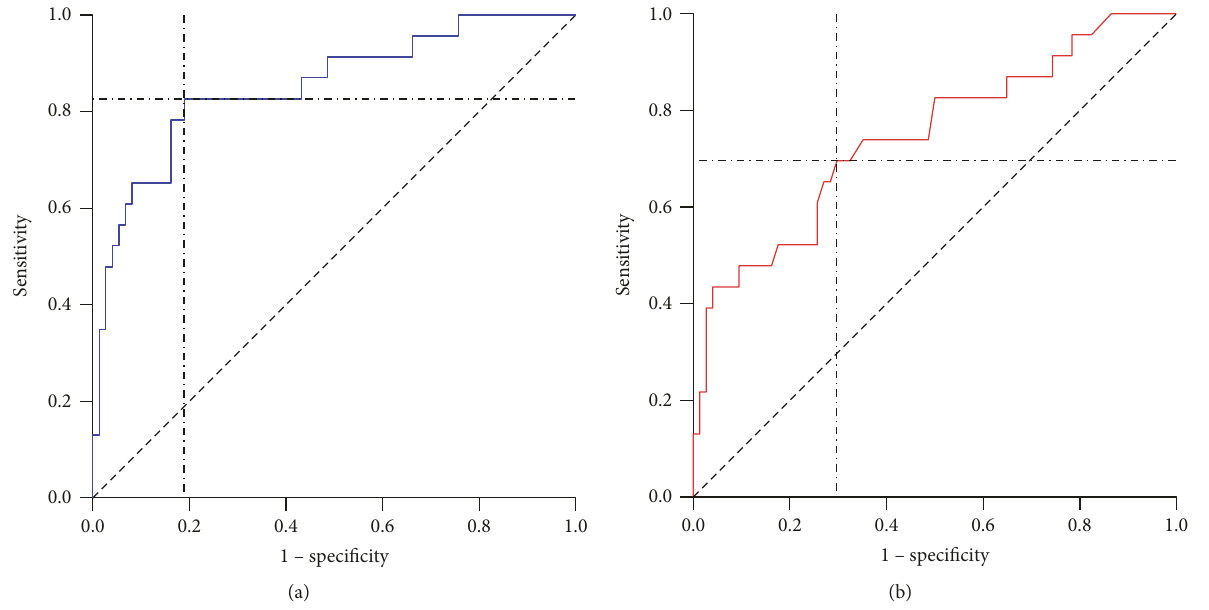
Figure 3: Receiver operating characteristic curve used to determine threshold values of isthmus length related to successful radioactive iodine therapy in patients with Graves ’ disease. (a) For a volume of 35 cm 3 , sensitivity was 82.6%, and speci fi city was 81.1% (AUC, 0.852; p < 0 001 ). (b) For an isthmus length of 5.2mm, sensitivity was 69.6%, and speci fi city was 70.3% (AUC, 0.746, p < 0 001 ).